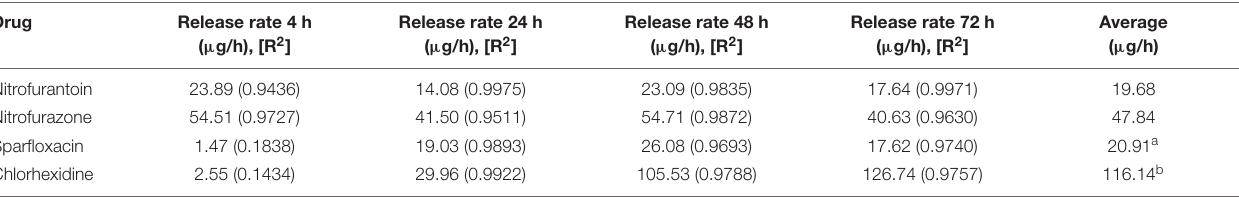
FIGURE 3 | Fluorescein isothiocyanate (FITC) migration through the interpenetrating polymer network (IPN) balloon. (A) Time lapse microscopy recorded at 0, 25, 43, and 72 min shows a time-dependent drug migration. (B) Z-stack at t = 0 shows a heterogenous material with large areas of hydrogel networks capable of absorbing FITC (green areas) and smaller silicone domains that remain unloaded (red arrows) and extends through the material (white arrows). (C) Experimental setup showing the time-lapse confocal laser scanning microscopy (CLSM) performed on an IPN catheter inflated with 5 ml of FITC. Frames in A- and Z-stack (B) are 146 µ m × 146 µ m. t, time in minutes. TABLE 1 | Drug release rate.